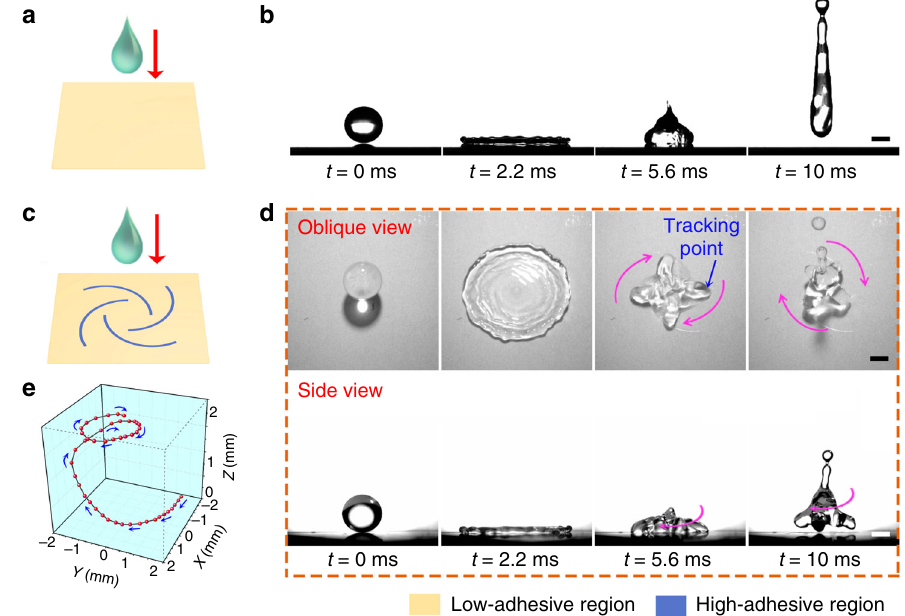
Fig. 1 Droplet impact dynamics. a , b Scheme and sequenced images of a water droplet impacting on a homogeneous hydrophobic and low-adhesive surface. The droplet spreads, homogeneously recedes, and bounces vertically upward from the surface. c Scheme of a water droplet impacting on a low- adhesive substrate with high-adhesive patterns. d Selected snapshots to show the synchronized oblique and side views of the droplet gyrating by impacting on the deliberately-designed adhesion-patterned substrate. After reaching maximum spreading and forming a circular fi lm, the liquid heterogeneously recedes accompanied by rotating in a pinwheel morphology. Four-lobed droplet gyrating in the air is achieved when the droplet departs from the substrate. e Three-dimensional trajectory of the tracking point marked at t = 5.6 ms in d . Time interval between the dots in the curve is 0.33 ms. In the tests above, the droplet diameter is 2.1 mm and the Weber number is 93. Scale bars: 1